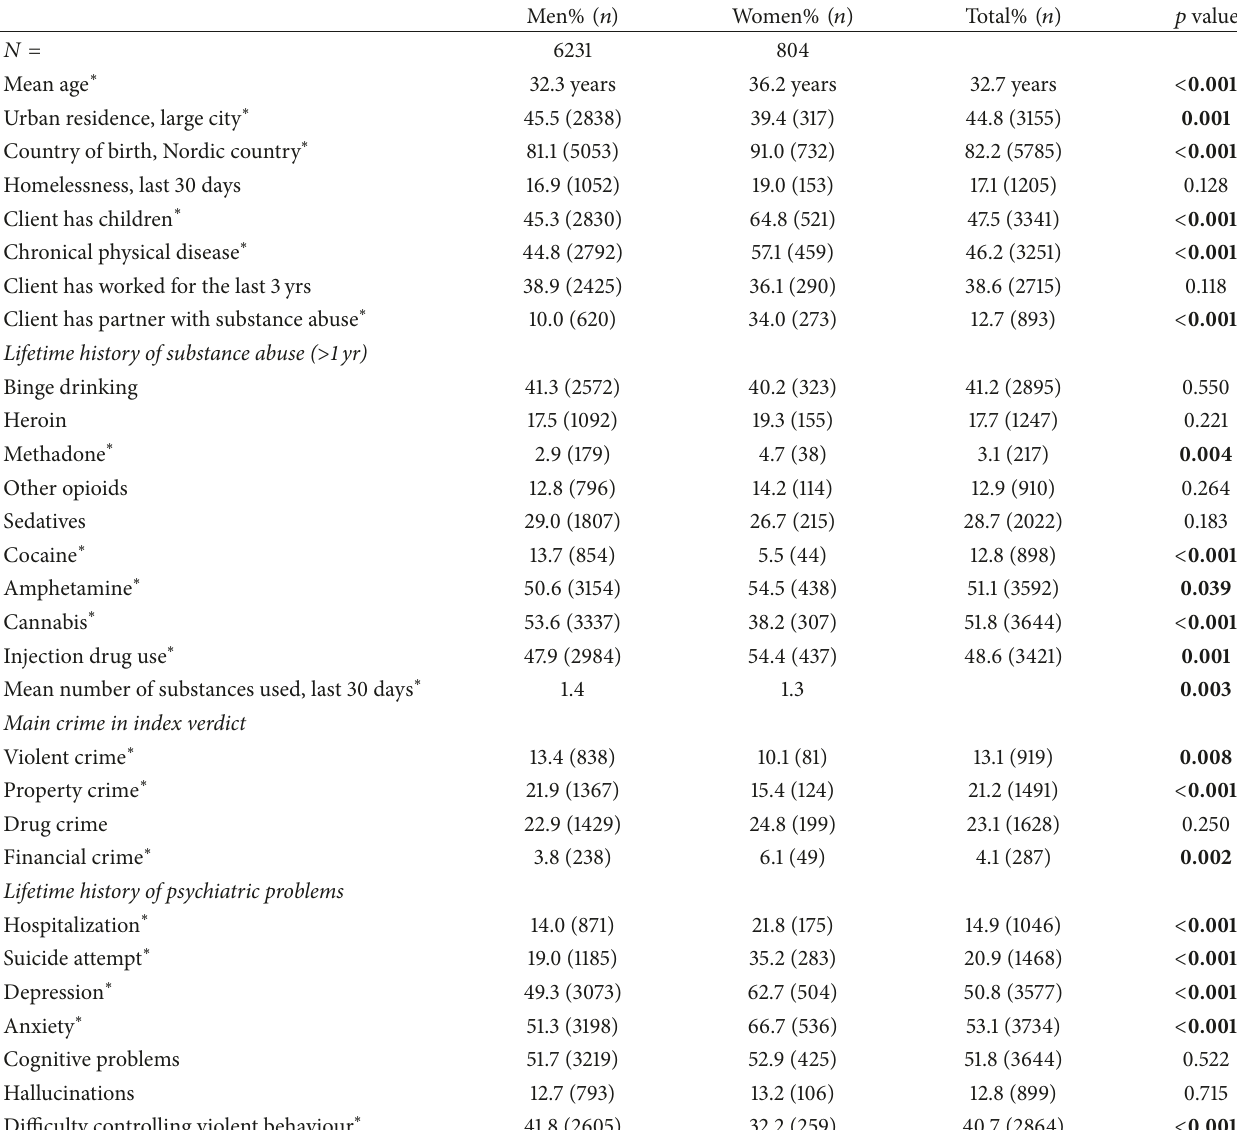
Table 1: Baseline